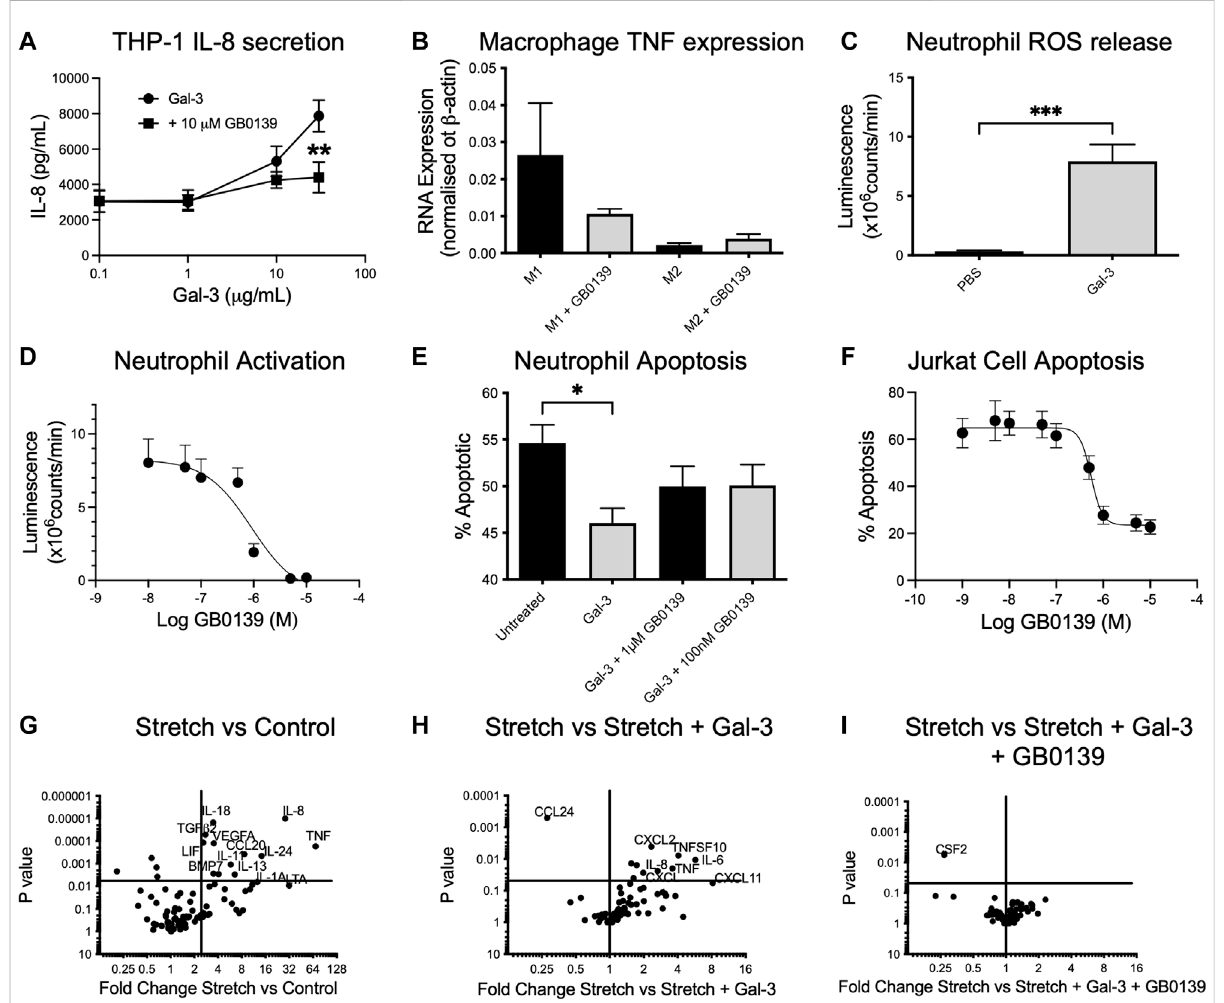
FIGURE 6 Effects of GB0139 in vitro . (A) THP-1 monocyte IL-8 secretion. THP-1 cells were differentiated with 10 nM PMA and treated with human recombinantGal-3±10 µMGB0139 for24 h. (B) Human monocyte-derivedmacrophages werecultured inthepresence ofGM-CSF (M1) orM-CSF (M2) for 6 days and then further activated with IFN- γ /LPS (M1) or IL-4 (M2) ± 10 µM GB0139 for 48 h. (C) Neutrophil ROS production. Neutrophils were primed with TNF α (10 ng/ml), prior to stimulation with 30 μ g/ml Gal-3. (D) GB0139 inhibition of Gal-3-induced neutrophil activation.